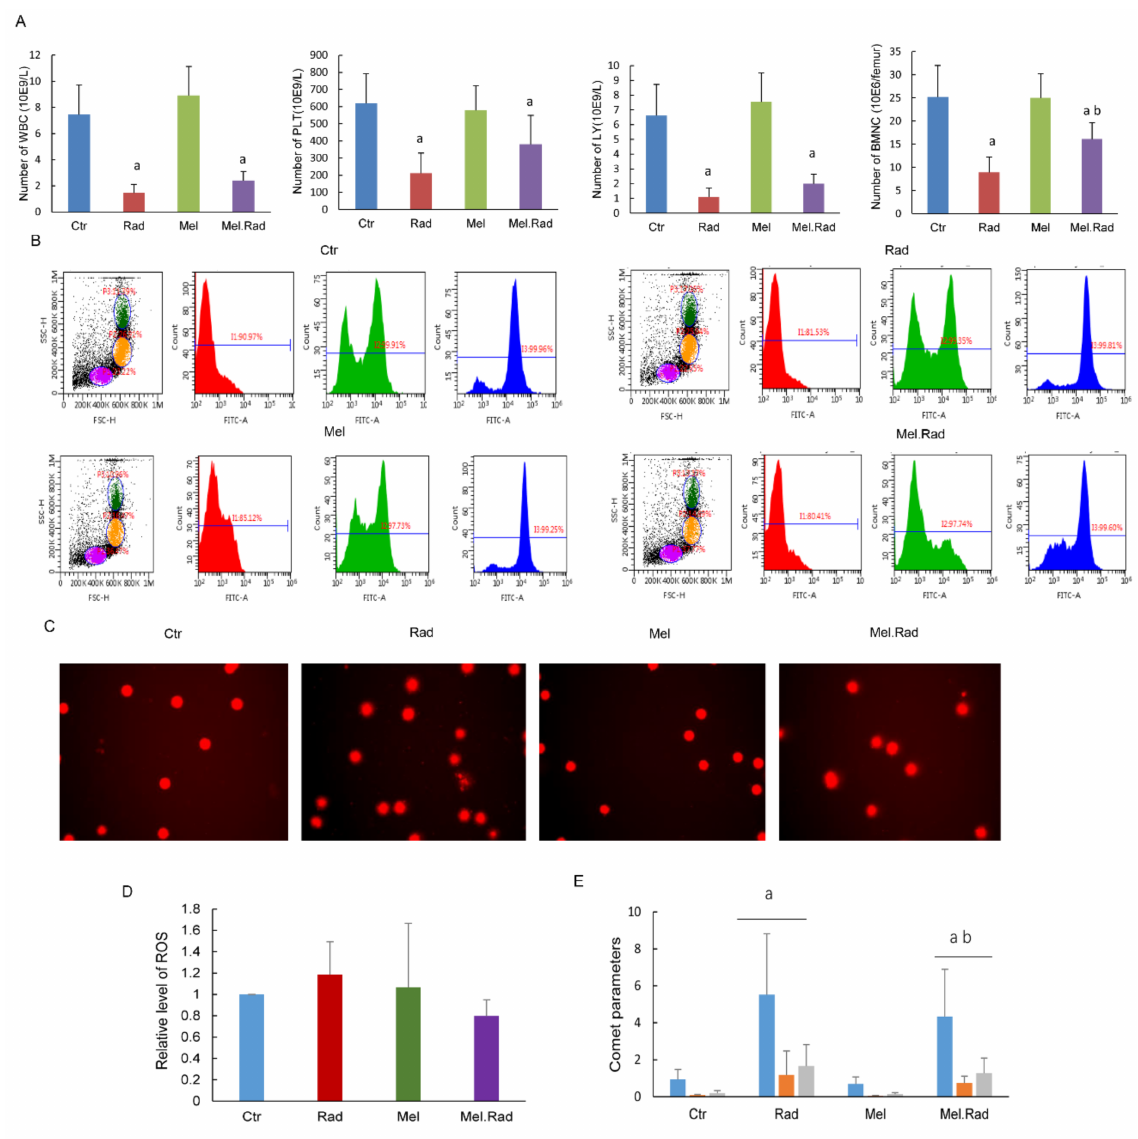
Figure 2. Effects of melatonin on the hematopoietic system of mice following TBI. Mice were treated with melatonin (10 mg/kg) daily for 5 consecutive days by intraperitoneal injection before exposure to a dose of 4 Gy TBI. A group of sham-irradiated control mice was regarded as a control. Whole blood and femurs of mice were harvested at 3 days following radiation. ( A ) The numbers of WBC, PLT, and LY from the whole blood and BMNCs from the femurs were detected. ( B ) Representative ROS images of flow cytometry. ( C ) The ROS levels of the BMNCs were analyzed. ( D ) Representative comet images of DNA damage for lymphocytes. ( E ) The frequency distribution of TDNA, TM, and OTM in lymphocytes was analyzed. Data are represented as mean ± SD, n = 6 mice/group. a p < 0.05 vs. Ctr; b p < 0.05 vs.